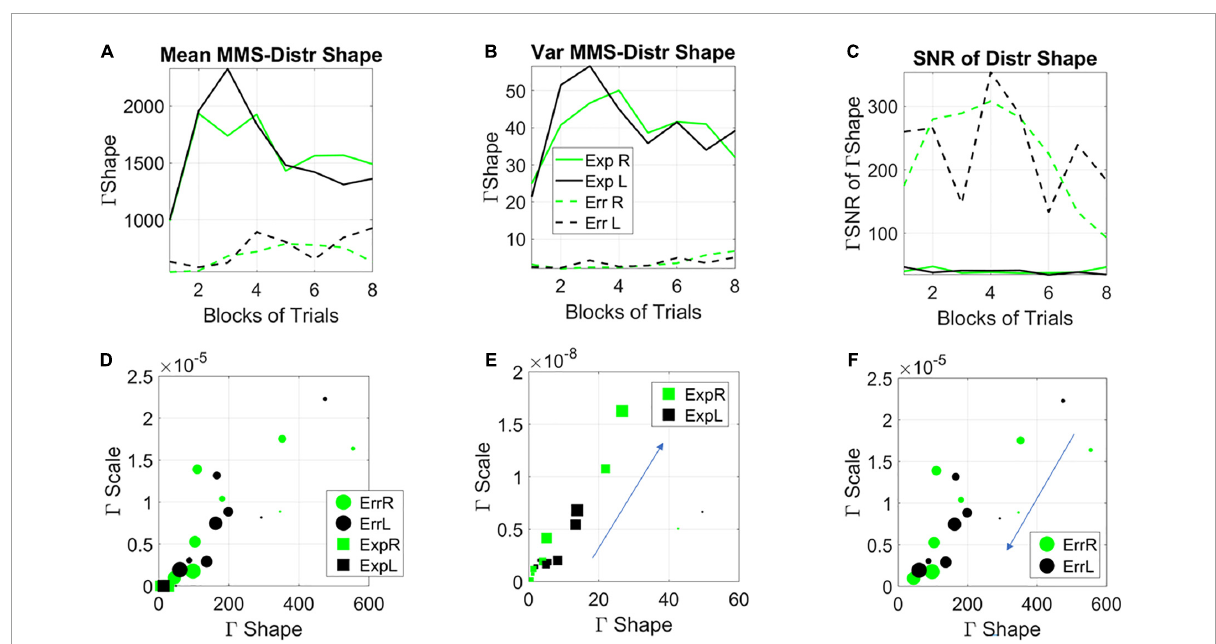
FIGURE9 Stochastic characterization of exploratory vs . error correction modes across blocks by subgroups. (A) The evolution of the empirically estimated mean based on the distribution of Gamma shape values extracted from the MMS. (B) The evolution of the empirically estimated variance of the distribution of Gamma shape parameters. (C) The SNR (mean/var ratio) for the exploratory and error-correction subgroups. (D) Block by block evolution of the empirically estimated shape and scale parameters of the continuous Gamma family of probability distributions. Block number is proportional to the marker size, with earlier blocks having smaller size and later blocks increasing in size. The exploratory mode is confined to the gamma shapes close to the memoryless exponential distribution, while the error corrective mode evolves from higher to lower values of the Gaussian regime of the Gamma family. Unfolding each case [exploratory (E) and error corrective (F) ] shows their convergence to a regime away from the memoryless exponential and tendency to more Gaussian like distributions. This convergent global behavior is congruent with the convergent local behavior of Figure 3